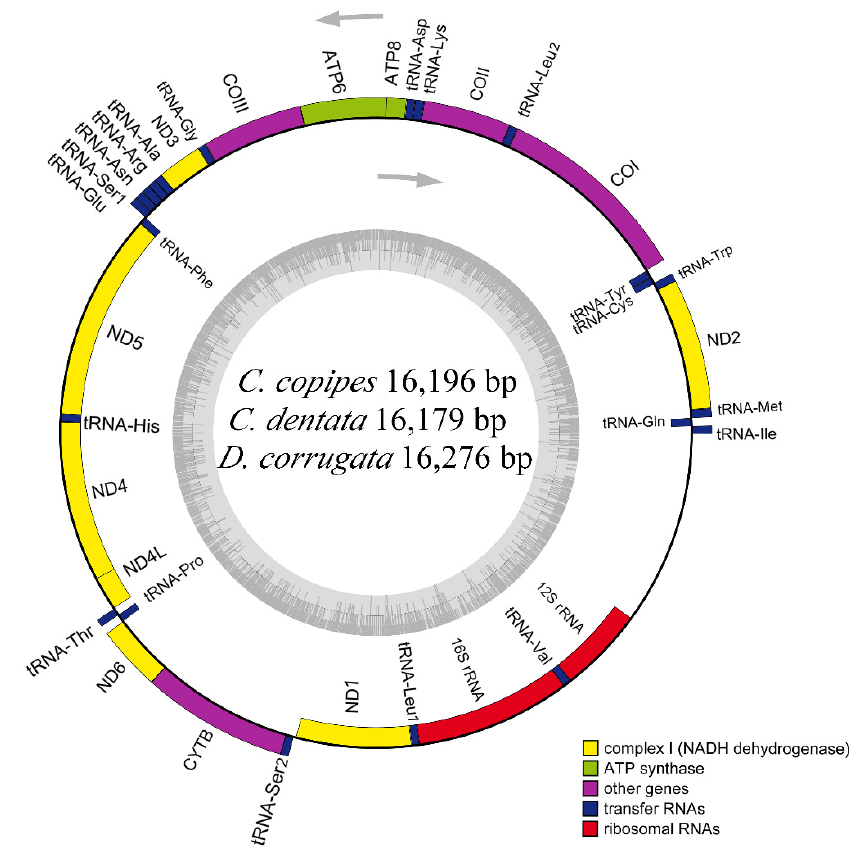
Figure 1. Gene maps of the mitogenomes of three Buprestidae species sequenced in this study. The three complete mitogenomes had high A + T contents of 71.76–76.59% and had a positive AT-skews and negative GC-skews. The overall AT-skews in the three entire